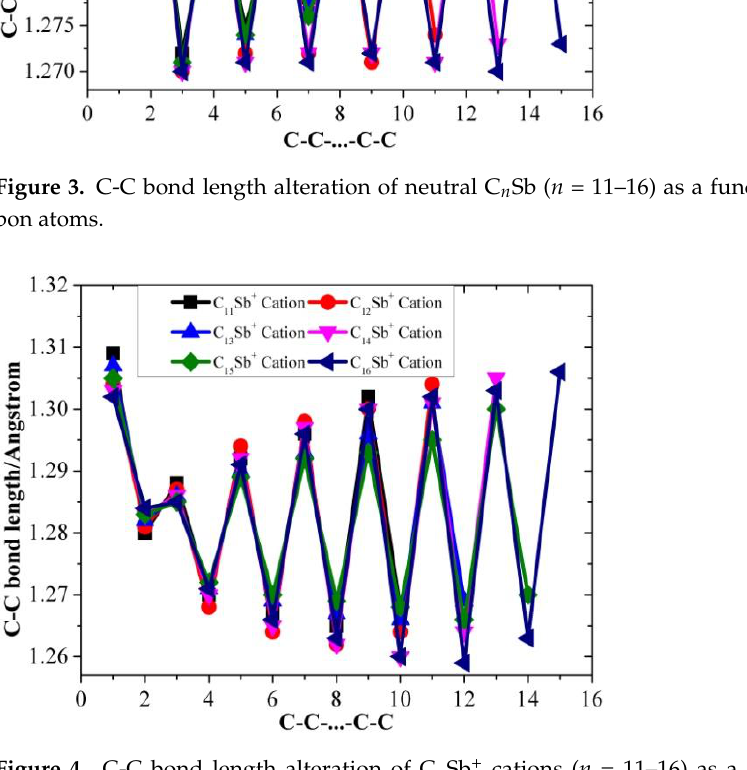
Figure 4. C-C bond length alteration of C n Sb + cations ( n = 11 – 16) as a function of number of carbon atoms.